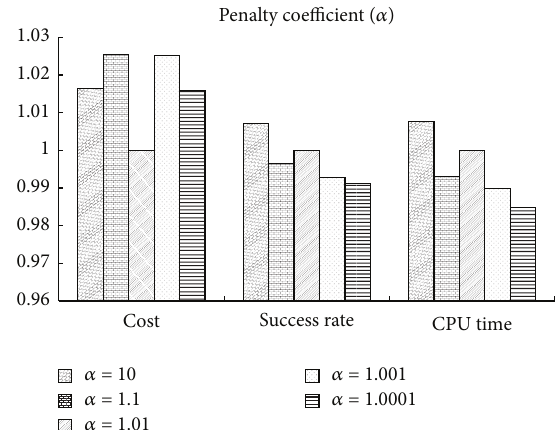
Figure 7: Comparison with different penalty coefficients (in per- centage relative to 𝛼 = 1.01 ).